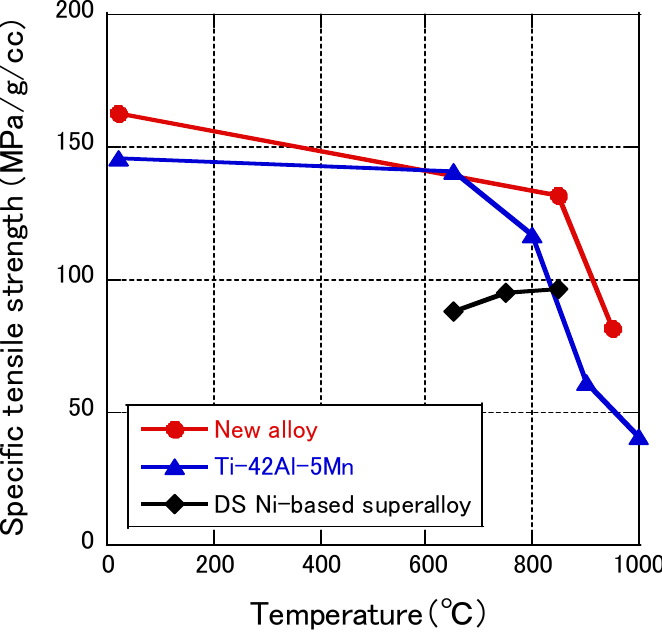
Figure 13. Tensile specific strengths of the new alloy and comparative materials.